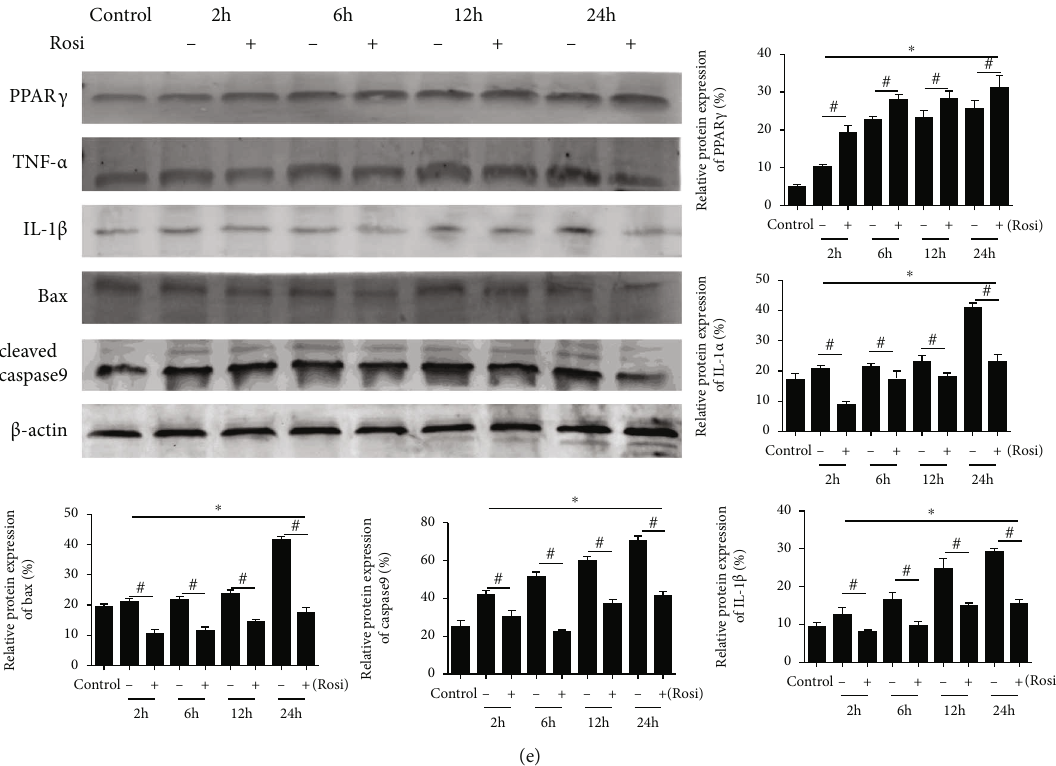
Figure 3: E ff ect of PPAR γ upregulation on liver function and pathology of mice in IR. Notes: (a) the levels of serum ALT and AST ( n = 5 , ∗ means p < 0 : 05 for Rosi versus IR after 2, 6, 12, and 24h, + means p < 0 : 05 for IR verse control); (b) the levels of serum TNF- α and IL-1 β ( n = 5 , ∗ means p < 0 : 05 for Rosi versus IR after 2, 6, 12, and 24h, + means p < 0 : 05 for IR verse control); (c) relative mRNA expression of TNF- α ( n = 5 , # means p < 0 : 05 for Rosi versus IR after 2, 6, 12, and 24h, + means p < 0 : 05 for IR verse control); (d) relative mRNA expression of Bax ( n = 5 , # means p < 0 : 05 for Rosi versus IR after 2, 6, 12, and 24h, + means p < 0 : 05 for IR verse control); (e) protein expression of PPAR γ , TNF- α , IL-1 β , Bax, and cleaved caspase9 ( n = 3 , # means p < 0 : 05 for si-PPAR γ versus IR after 2, 6, 12, and 24h, ∗ means p < 0 : 05 for IR verse